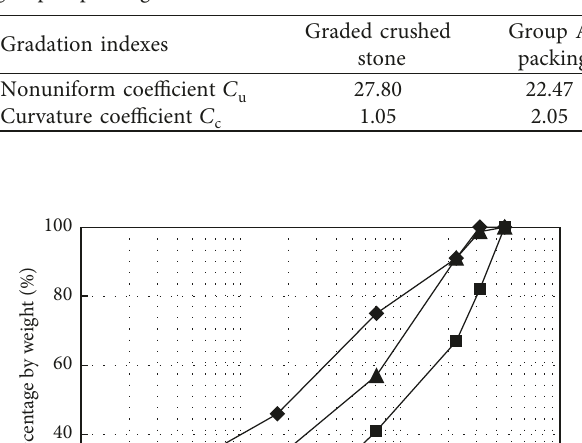
Table 1: Gradation indexes of the graded crushed stone and the group A packing.